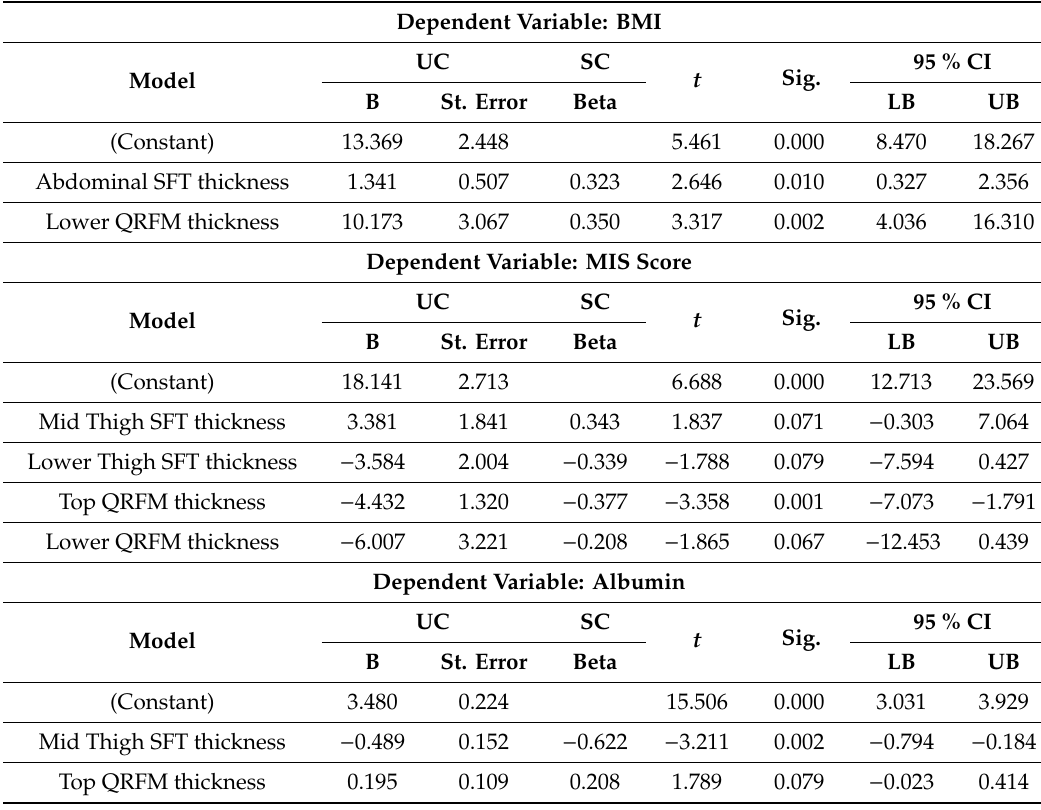
Table 2. Correlation between SFT / QRTM thickness and nutritional indexes (BMI, albumin, MIS score) in hemodialysis